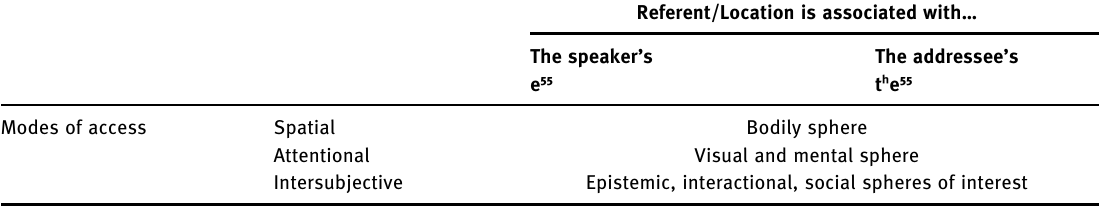
Referent/Location is associated with …